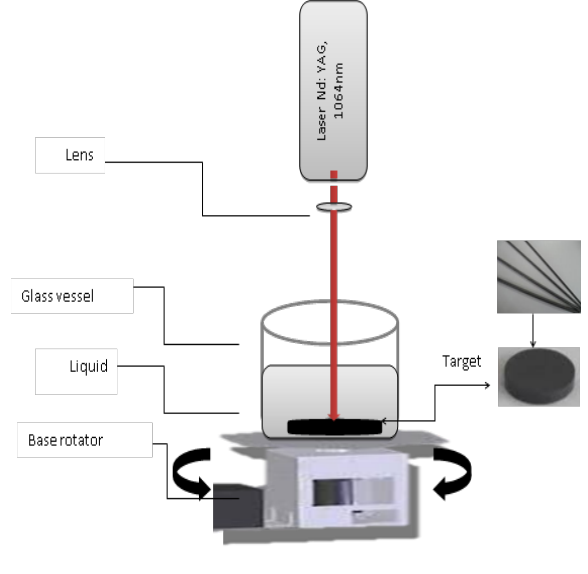
Fig.1: Experimental setup for carbon nanoparticles